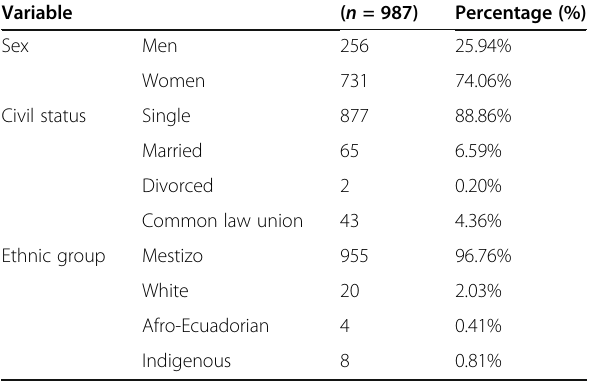
Table 1 Sociodemographic characteristics of the sample